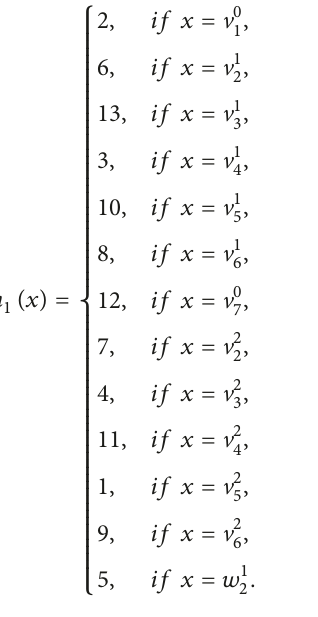
Figure 9: Bijective function ℎ 2 (𝑥)